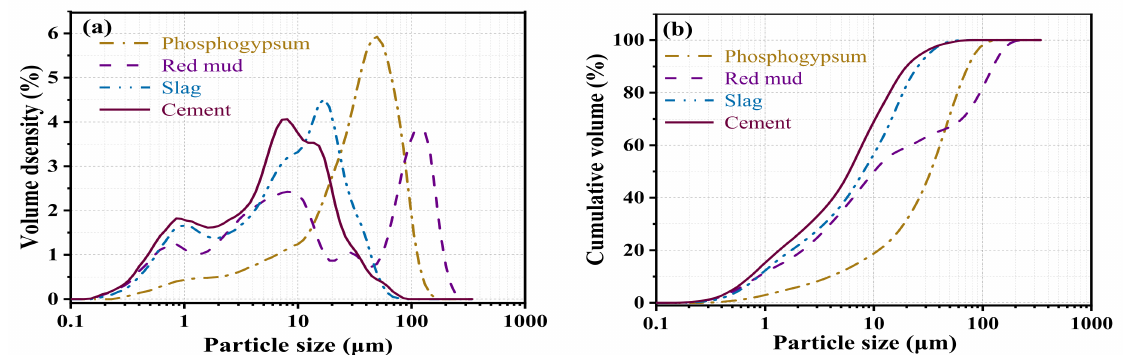
8.97, and 6.63 µ m.